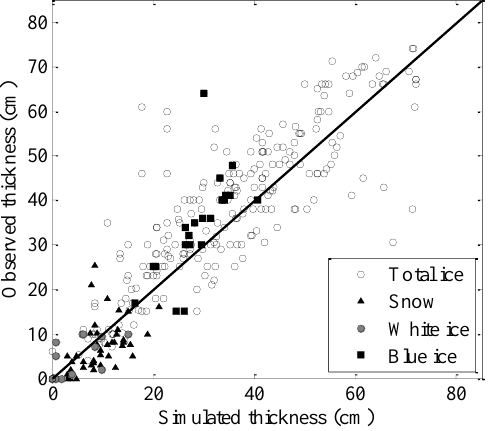
Figure 2. Comparison between observations and simulated total ice, snow cover, white ice, and blue